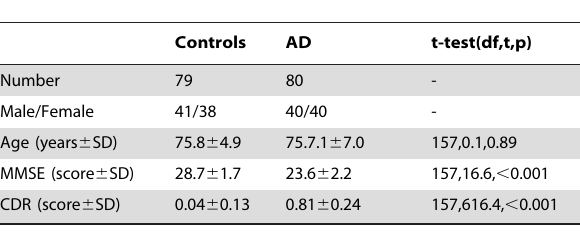
Table 1. Subject group characteristics for